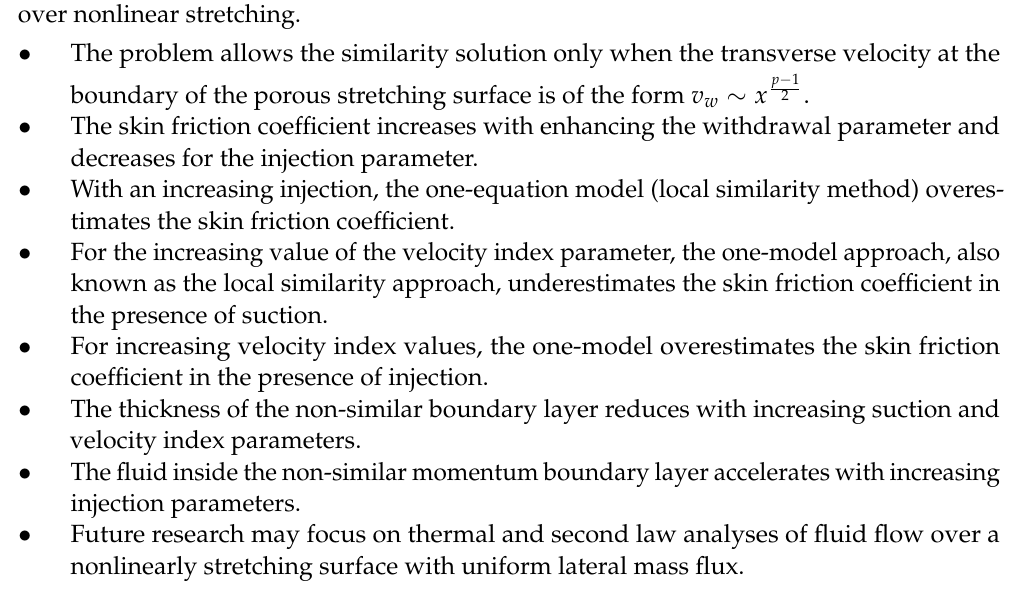
Figure 4. Velocity profile against the various values of velocity index parameter when 0.5.